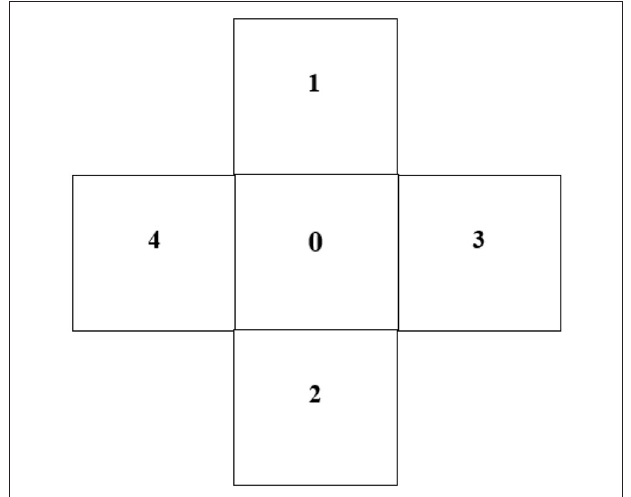
FIGURE 1 | Representation of the cross test.